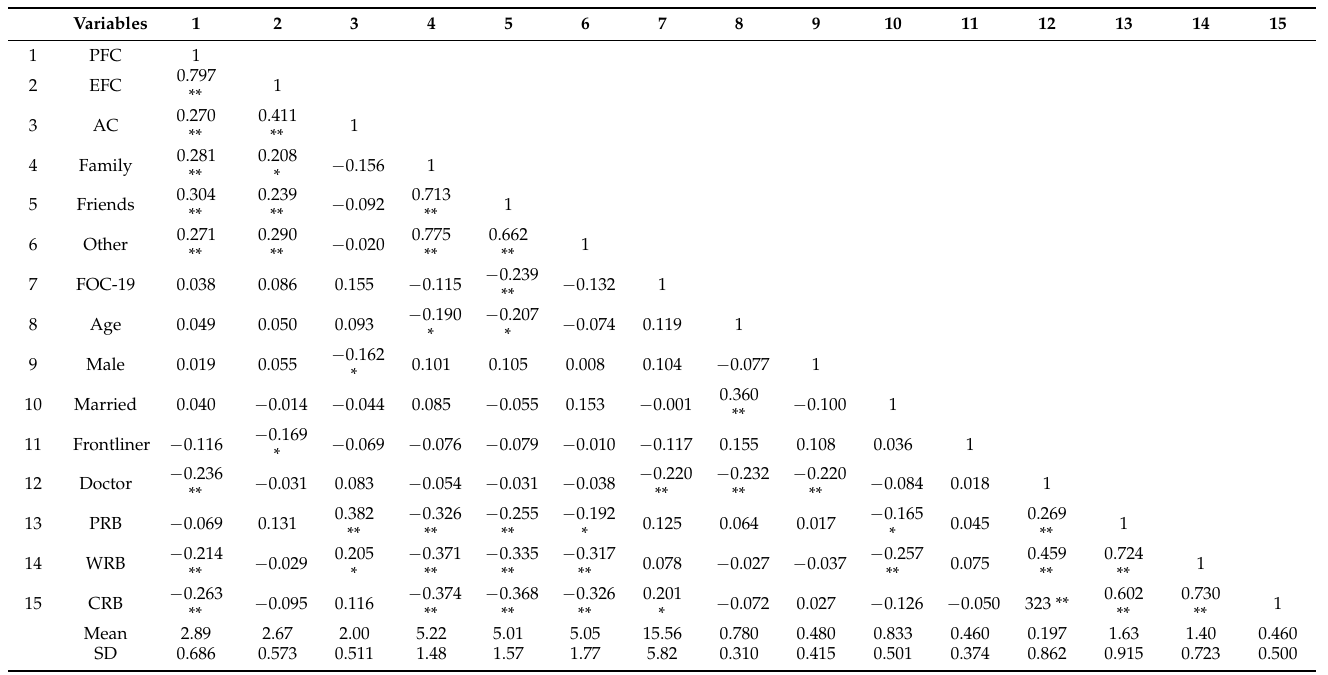
Table 3. Pearson correlations between